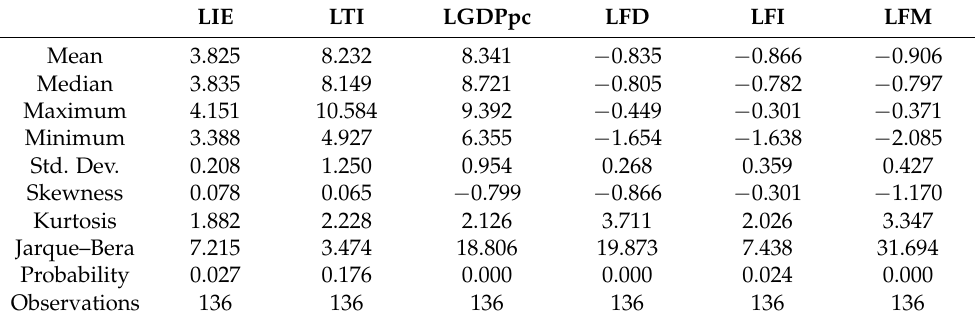
Table 1. Descriptive statistics.